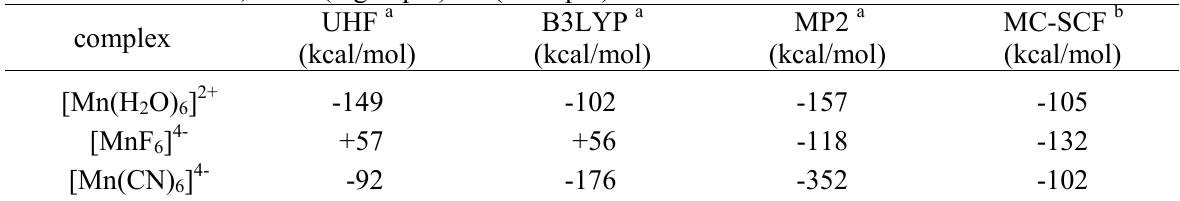
complexes using different 6